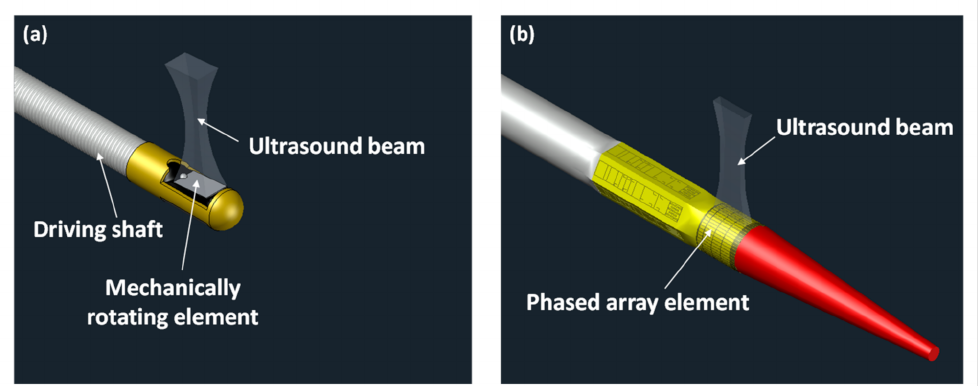
Figure 4. Schematic diagrams of the IVUS transducers: ( a ) mechanical IVUS transducer and ( b ) solid- state IVUS